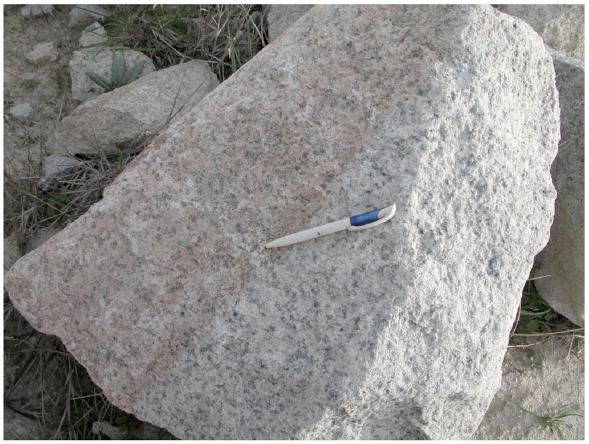
Fig. 5. Azul Platino and Amarillo Platino in the quarry. The latter is the weathered facies of the